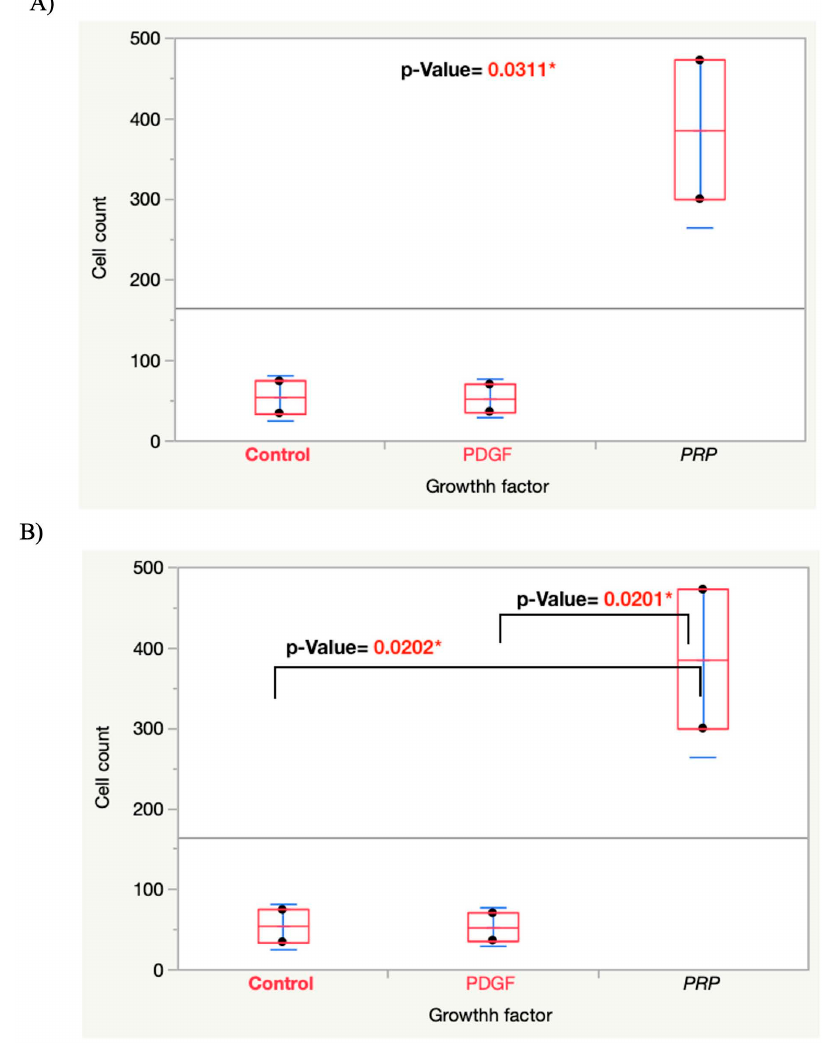
Figure 8. ( A ) Graph showing one-way ANOVA for the migration assay pilot study “cell count” by “Growth factor” (N = 2) among the groups. ( B ) Graph showing pairwise student t-test analysis be- tween each pair of the groups.